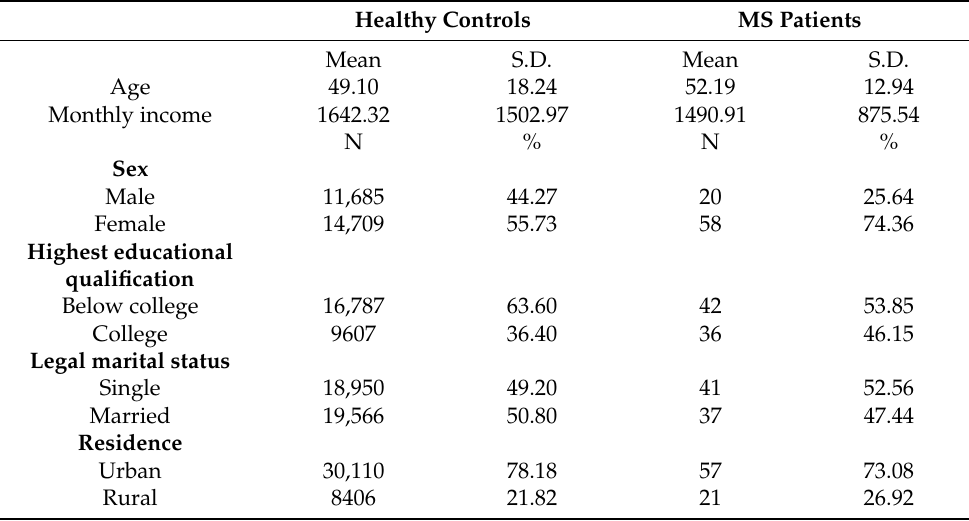
Table 1. The demographic characteristics of healthy controls and MS